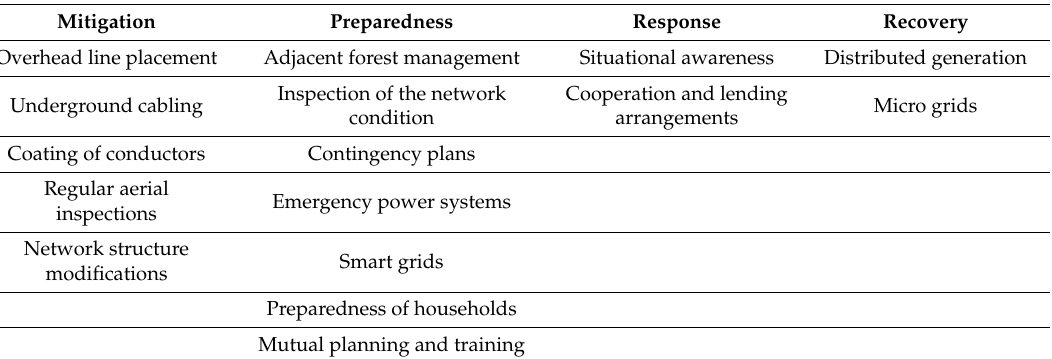
Table 2. Examples of risk mitigation measures identified in the case study to improve the resilience of electricity distribution networks against extreme weather events (EWE)